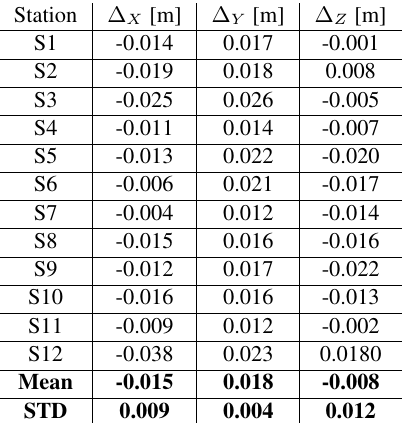
Table 5. Averages of residuals for each station obtained by